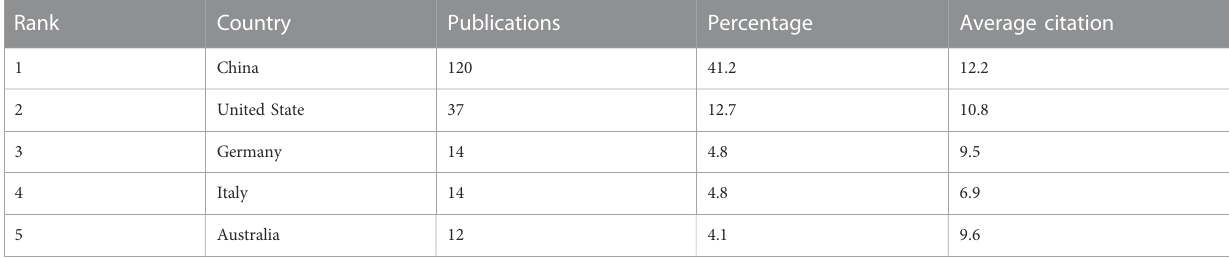
TABLE 2 Top 5 countries contributed to research publications in the fi eld of additive manufacturing technology in pelvic surgery.